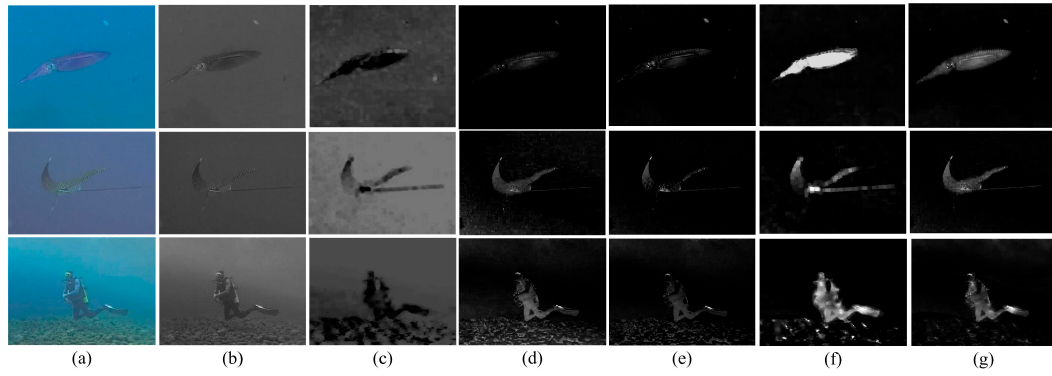
Figure 2. Typical samples of the region of interest (ROI) detection. ( a ) Color; ( b ) intensity; ( c ) transmission; ( d ) color global contrast; ( e ) intensity global contrast; ( f ) transmission global contrast; and ( g ) ROI detection.